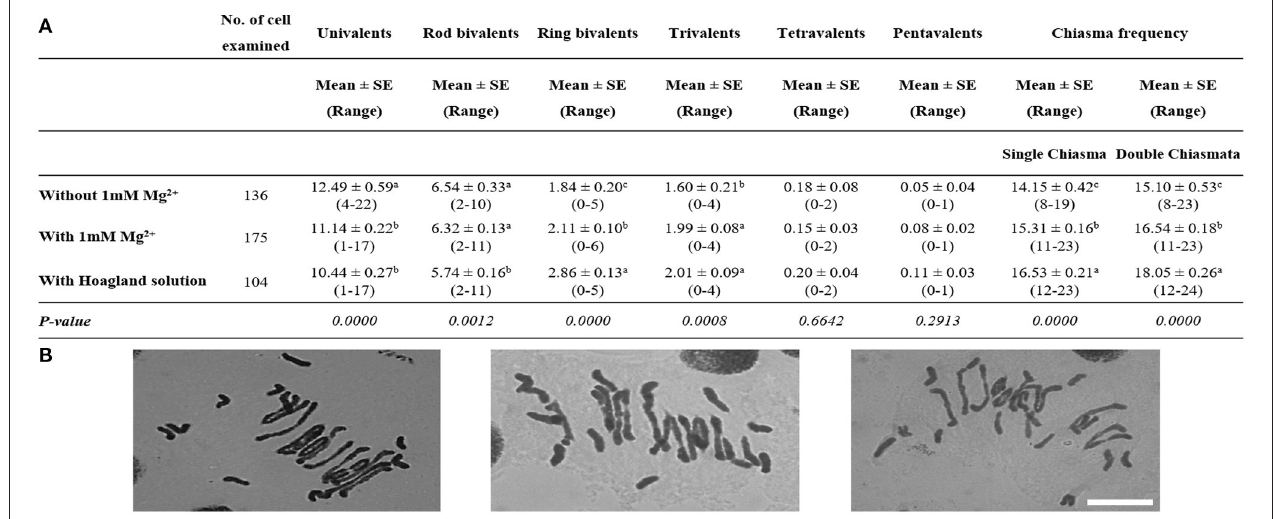
FIGURE 2 | Effect of either 1mM Mg 2 + or Hoagland solution on homoeologous CO frequency of T. aestivum cv. Chinese Spring Tazip4-B2 ph1b mutant- Ae. variabilis hybrids. (A) Frequencies of univalents, bivalents, trivalents, tetravalents, pentavalents and chiasma frequency (single and double chiasmata) were scored at meiotic metaphase I in Tazip4-B2 ph1b mutant- Ae. variabilis hybrids treated with either 1mM Mg 2 + or Hoagland solution. Values in parenthesis indicate range of variation between cells. P < 0.05 indicates significant differences according to LSD test. Different letters indicate significant differences between treatments. (B) Representative meiotic configurations of Tazip4-B2 ph1b mutant- Ae. variabilis hybrids. From left to right: water alone, 1mM Mg 2 + treatment and Hoagland solution treatment. Bar: 20 µ